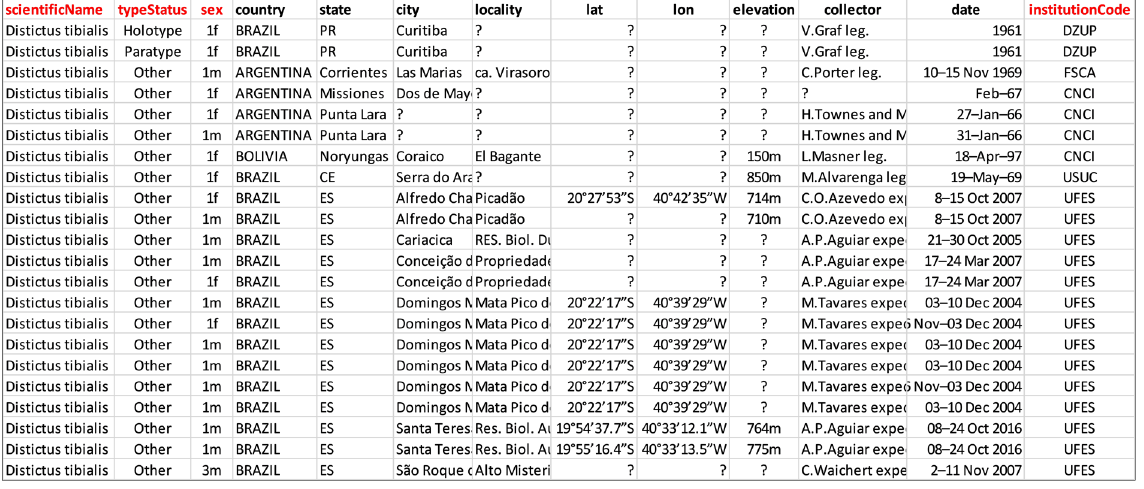
Fig. 3. Resulting order after multiple sorting according to the columns typeStatus, country, state, city and locality, in that order. This sequence of column names corresponds to the variable Sorting Order in the Gridit